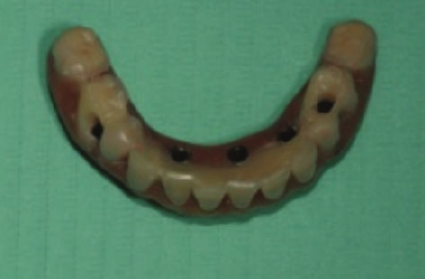
Figure10:Thedenturemodifiedtobeusedasinterimimplantborne